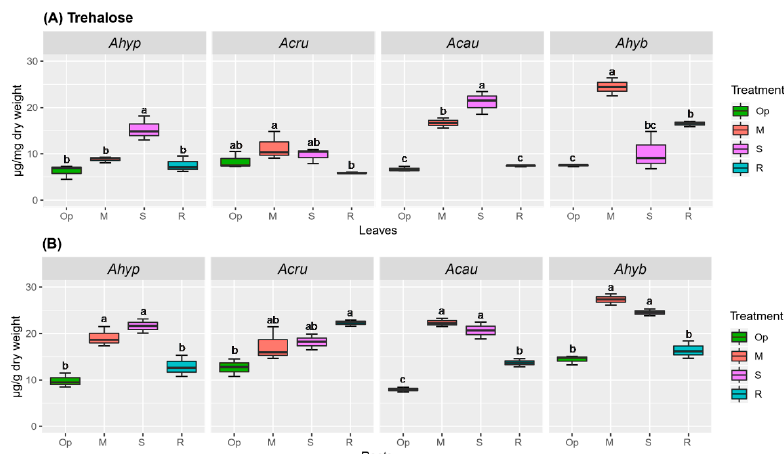
Figure 11. Trehalose (Tre) accumulation in amaranth plants subjected to water-deficit stress. Tre content in ( A ) leaves and ( B ) roots of Amaranthus hypochondriacus (Ahypo), A. cruentus (Acru), A. caudatus (Acau)